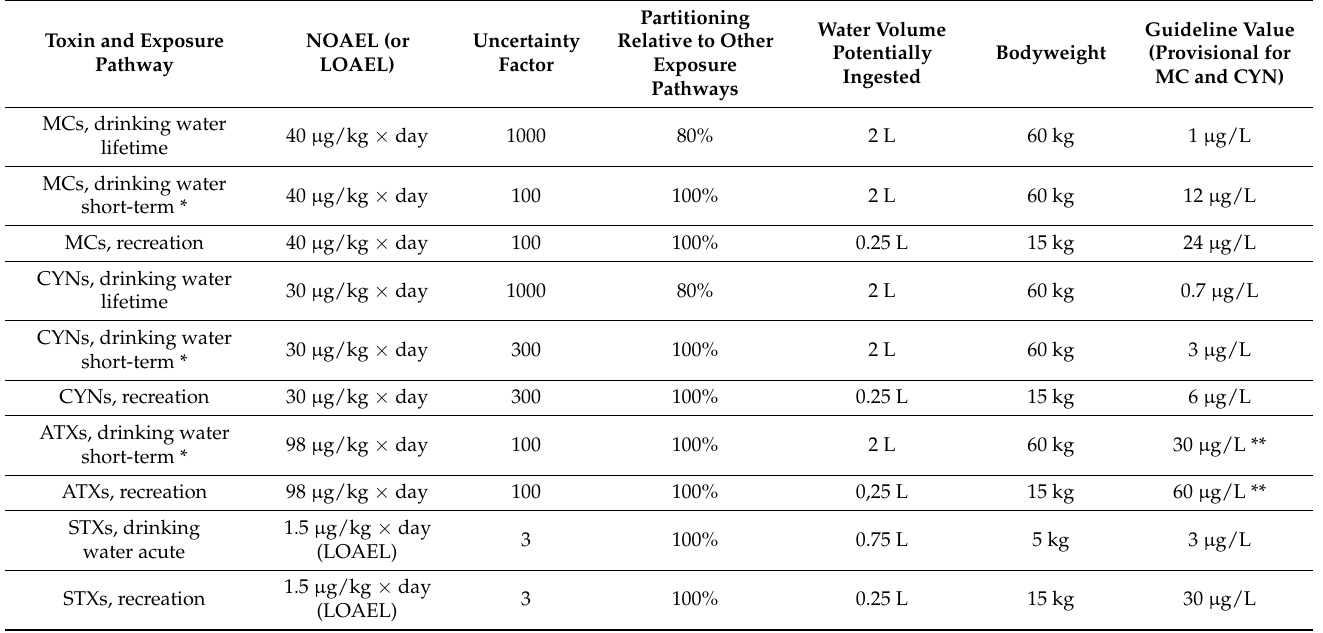
Table 2. WHO cyanotoxin guideline values and health-based reference values, respectively, and assumptions used for their derivation. MCs: microcystins; CYNs: cylindrospermopsins; ATXs: anatoxins; STXs: